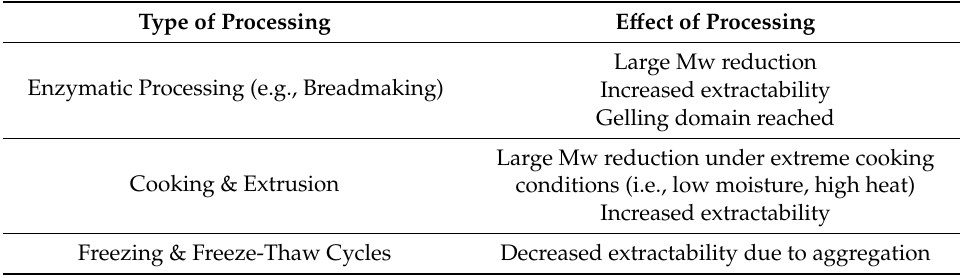
Table 1. Overview of typical processing-induced changes in cereal β -glucan